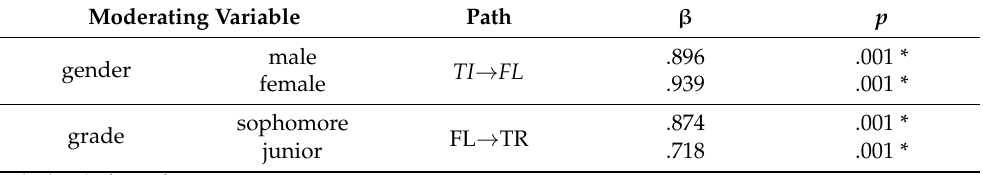
Table 12. Comparison between path coefficients with significant moderating